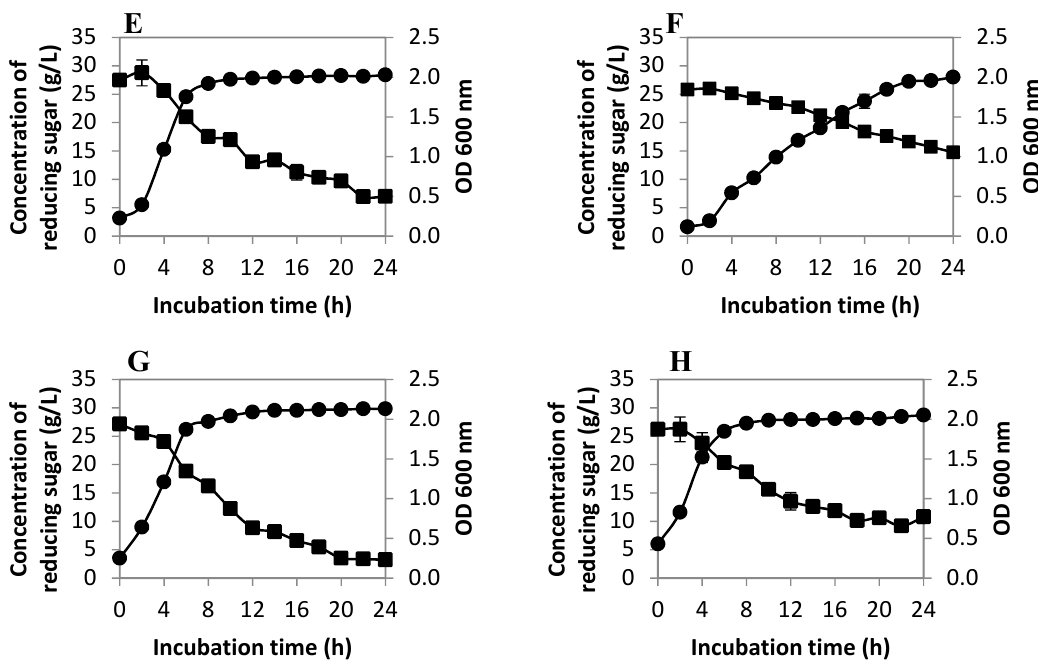
Figure 2. The cell growth profile ( • ) and reducing sugar consumption ( (cid:4) ) of different LAB cultivated in de Man, Rogosa, and Sharpe (MRS) medium: ( A ) Pediococcus acidilactici UP-1; ( B ) Pediococcus pentosaceus UP-2; ( C ) P. pentosaceus UB-6; ( D ) P. pentosaceus UB-8; ( E ) P. pentosaceus UL-2; ( F) P. acidilactici UL-3; ( G ) Lactobacillus plantarum UL-4; and ( H ) P. pentosaceus UL-6.